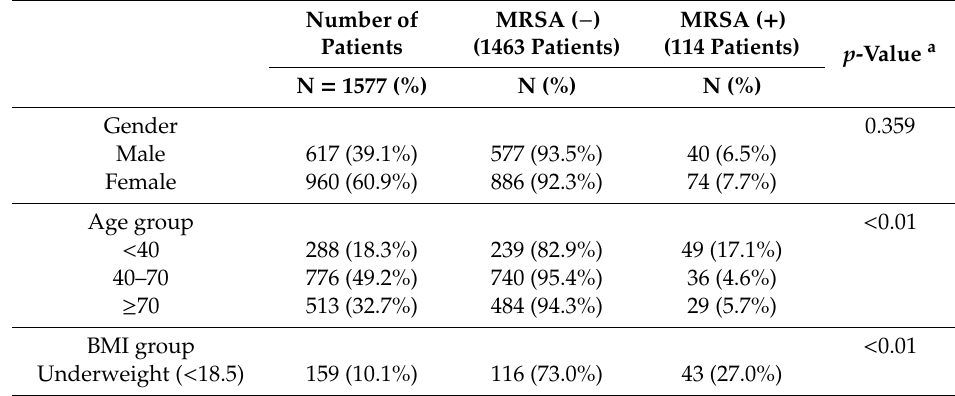
Table 2. Descriptive logistic regression analysis from data obtained at admission (demographics, socio-economic